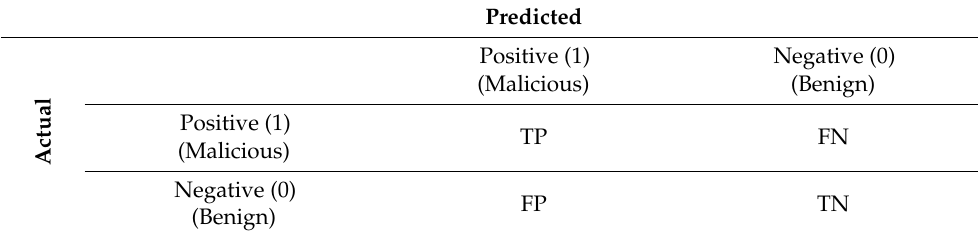
Table 3. Confusion